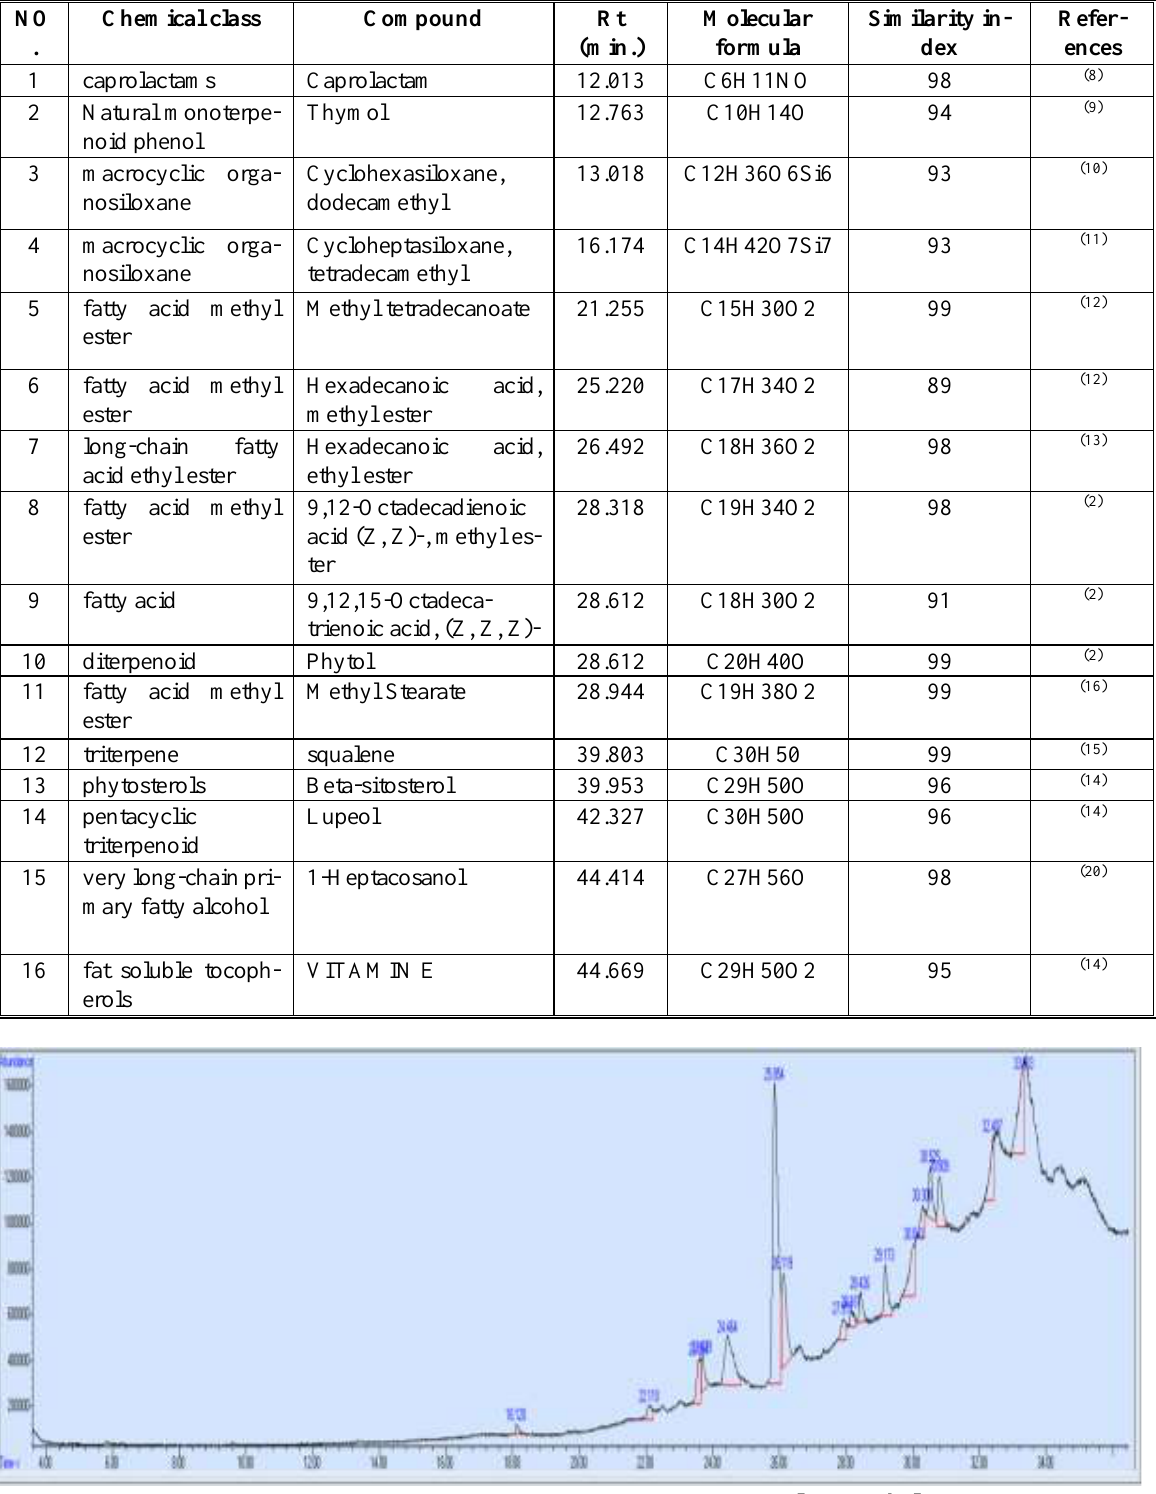
Table 5. GC-MS analysis of petroleum ether leaves extract of Leucaena leucocephala by cold extraction method.